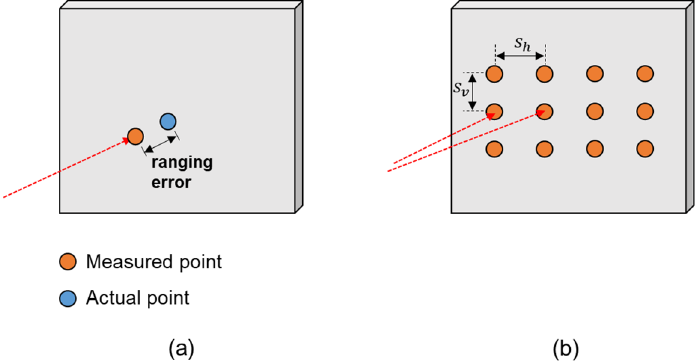
Figure 11. Scanned data quality with regard to ( a ) ranging error and ( b ) spatial resolution.